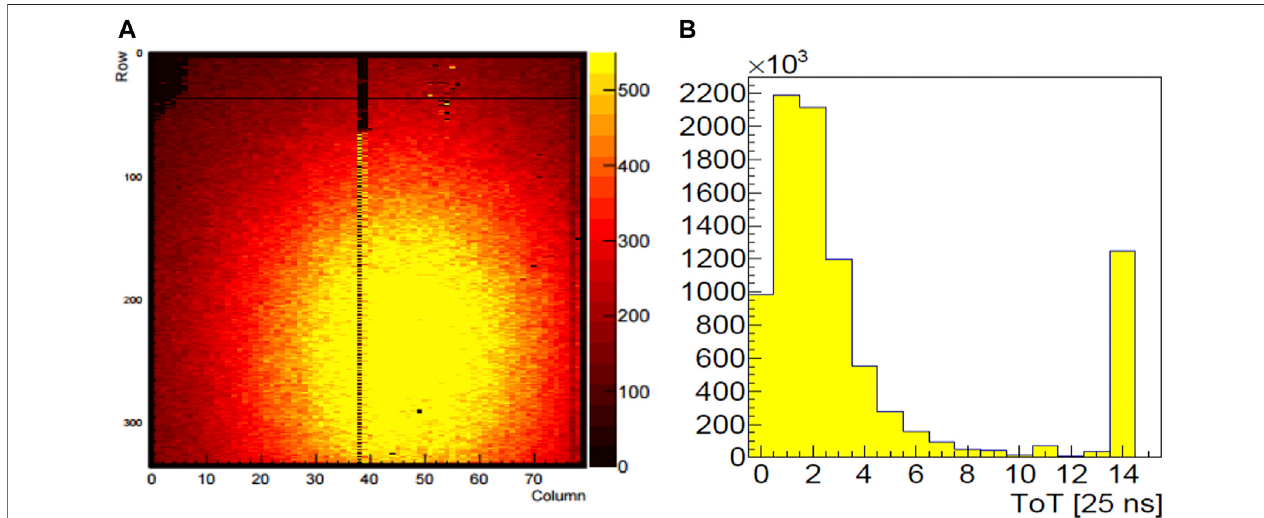
FIGURE 8 | Response to the 90 Sr beta radioactive source before irradiation at room temperature. (A) Pixel occupancy and (B) time over threshold spectrum. The counts at channel 14 is a feature of the FE-I4 readout chip, which uses bin 14 as over fl ow for all the signal charges that are over the maximum